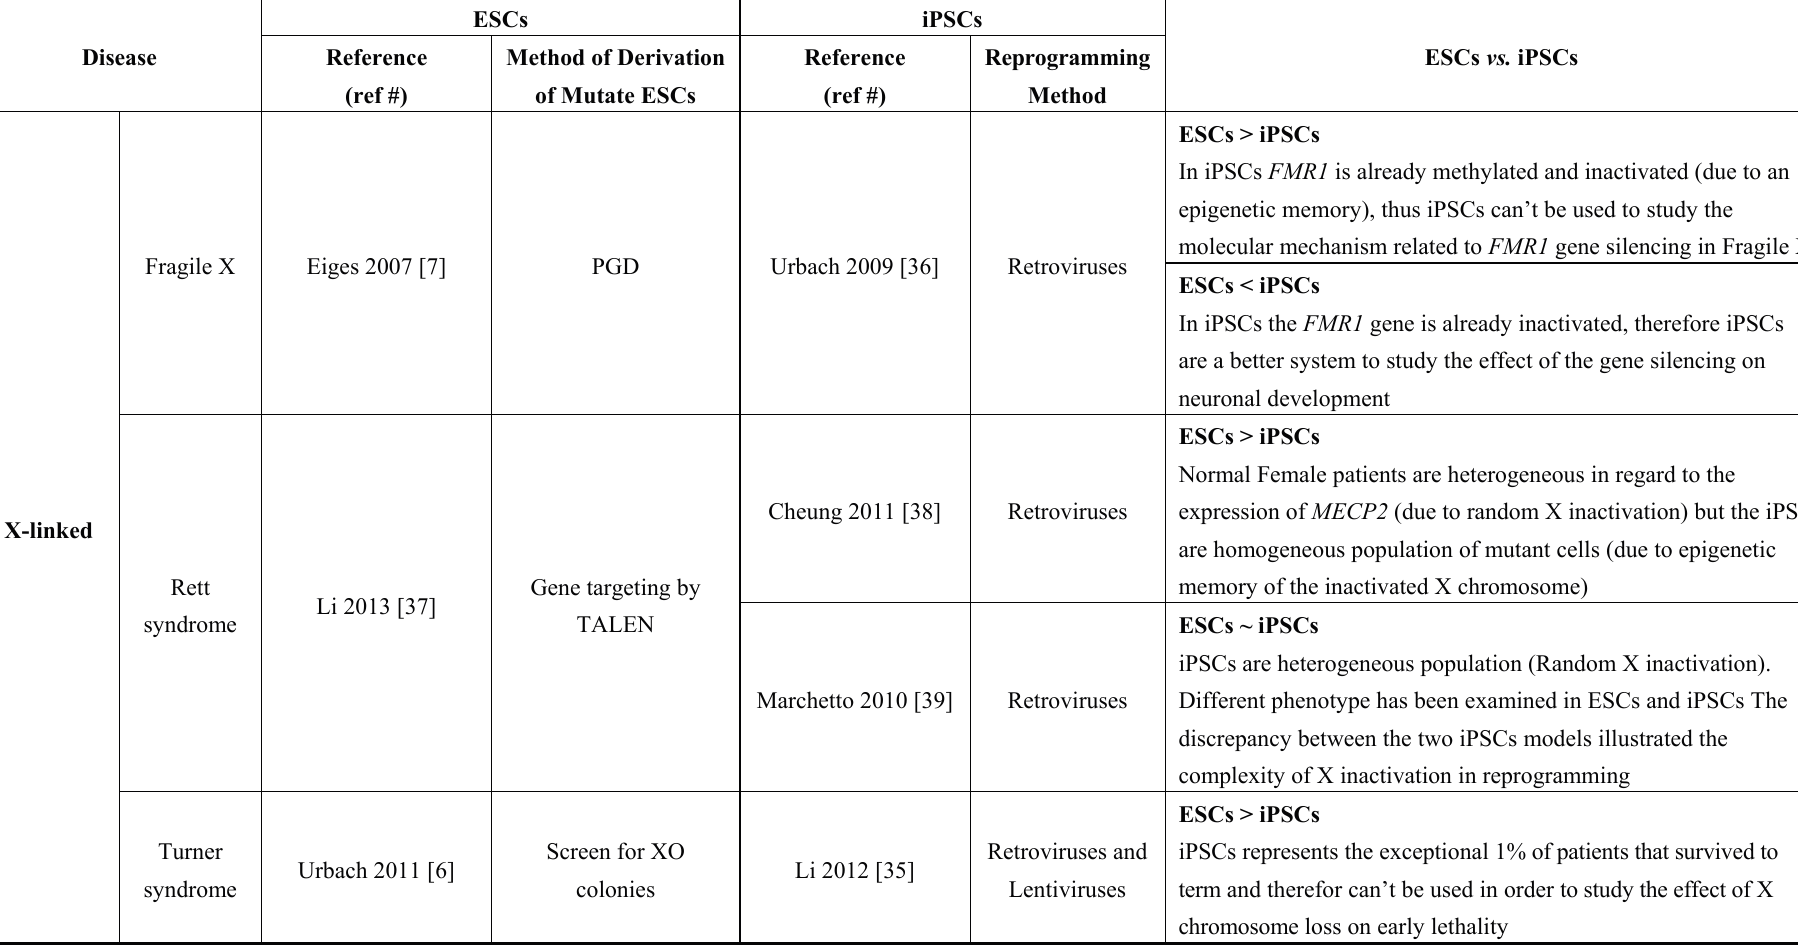
Table 1. Comparison between ESCs and iPSC models for human genetic